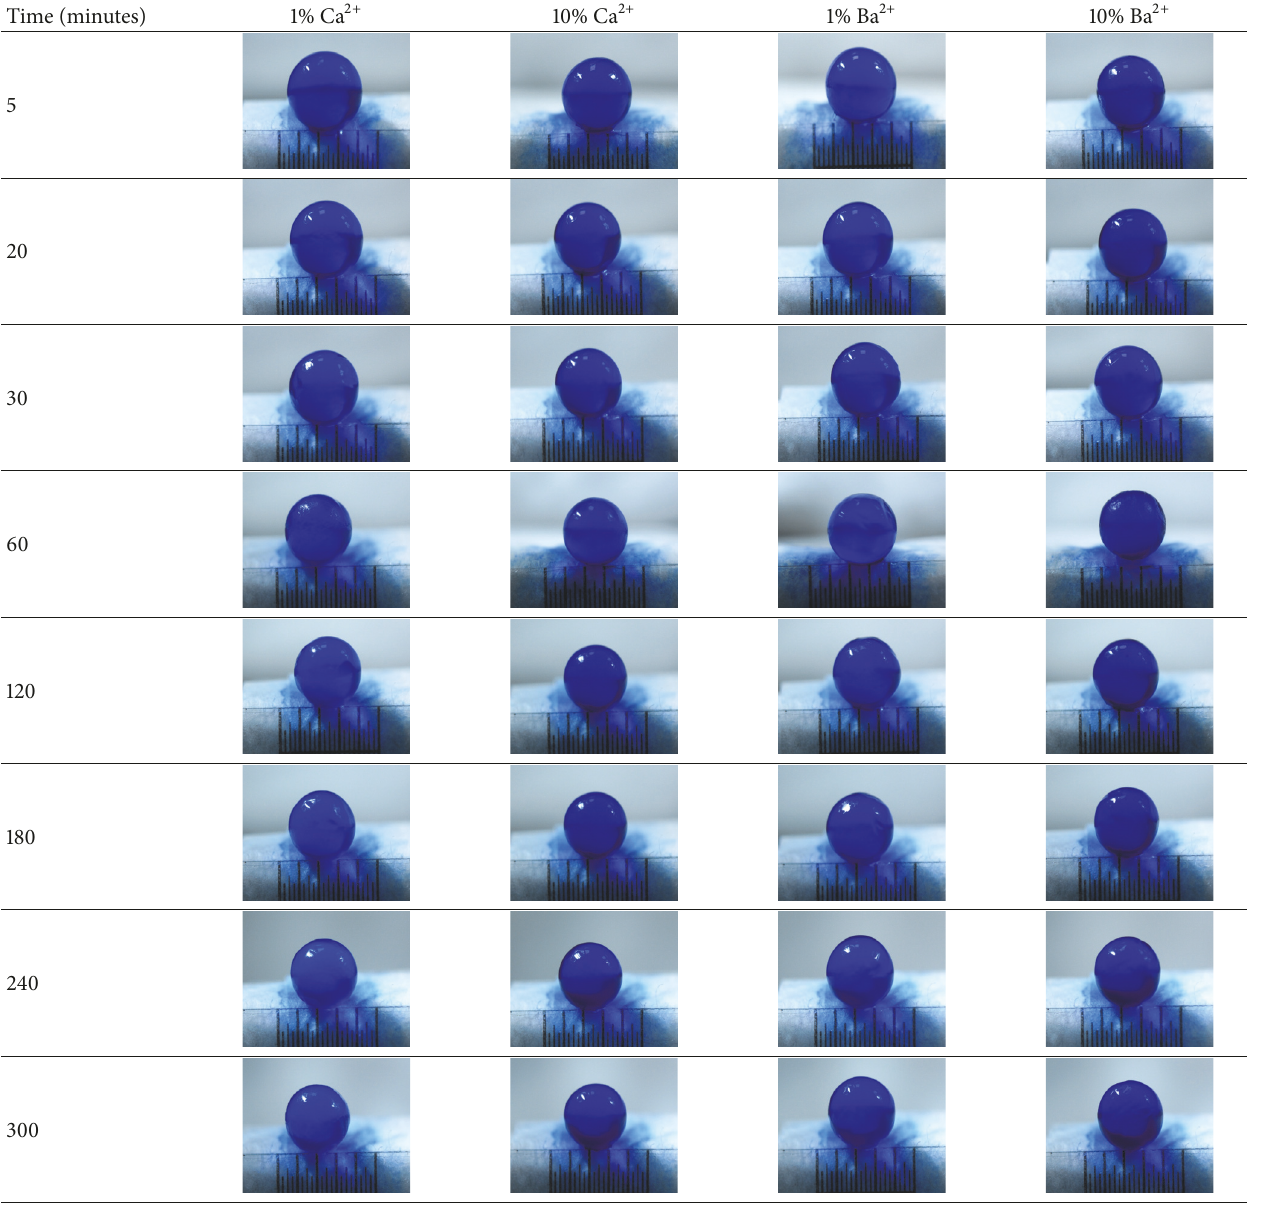
Table 2: Photographs of alginate beads incubated in different concentrations of Ca 2+ and Ba 2+ at a low temperature (8 ∘ C) for various gelling